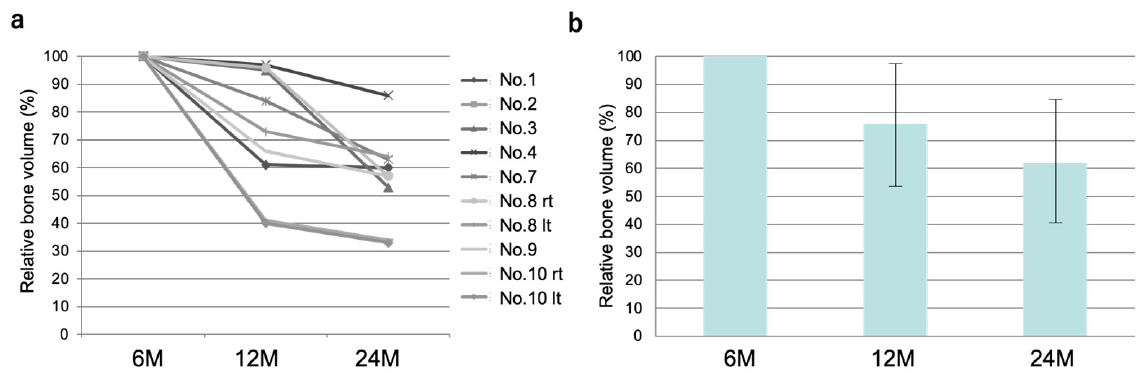
Figure 6. Time course of bone volume: ( a ) individual changes and ( b ) average bone volume.